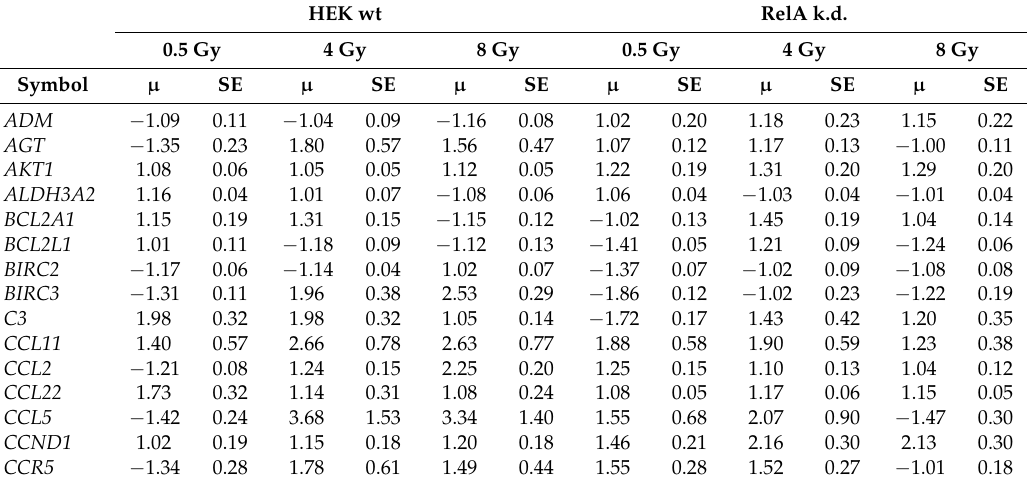
Table A5. Relative gene expression in HEK-pNF- κ B-d2EGFP/Neo L2 (HEK wt) and HEK shRNA RelA (RelA k.d.) cells after irradiation using the RT2 Profiler PCR array: